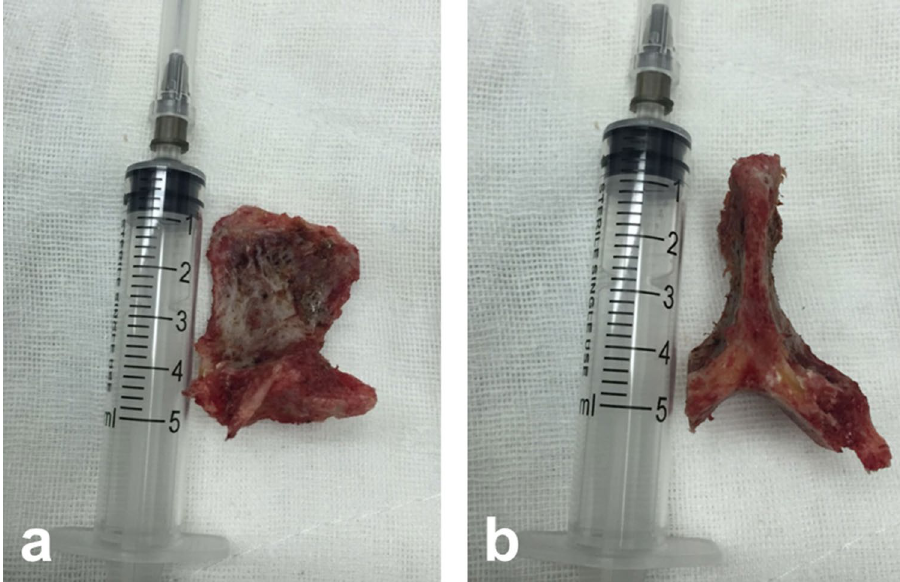
Figure 1. The specially formed autologous spinous process for interbody fusion obtained in the operation area ( a A–P position, b lateral position). The cortex bone of the spinous process was grinded before